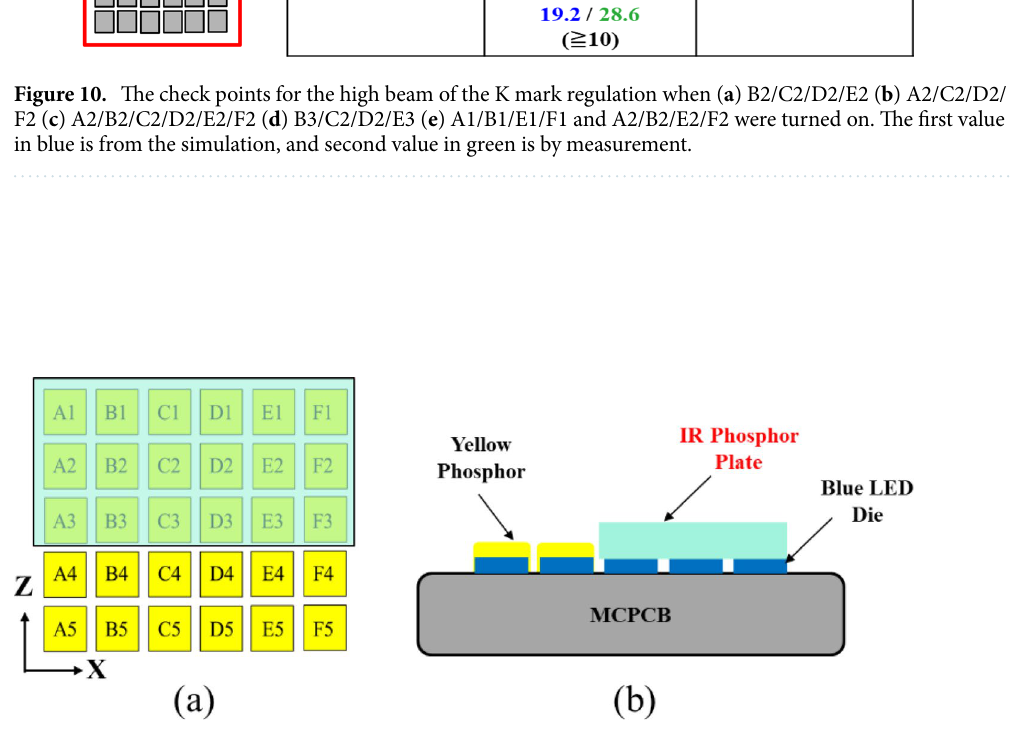
Figure 11. The schematic diagram of the LED matrix with yellow and IR phosphors. ( a ) The top view, and ( b ) the side